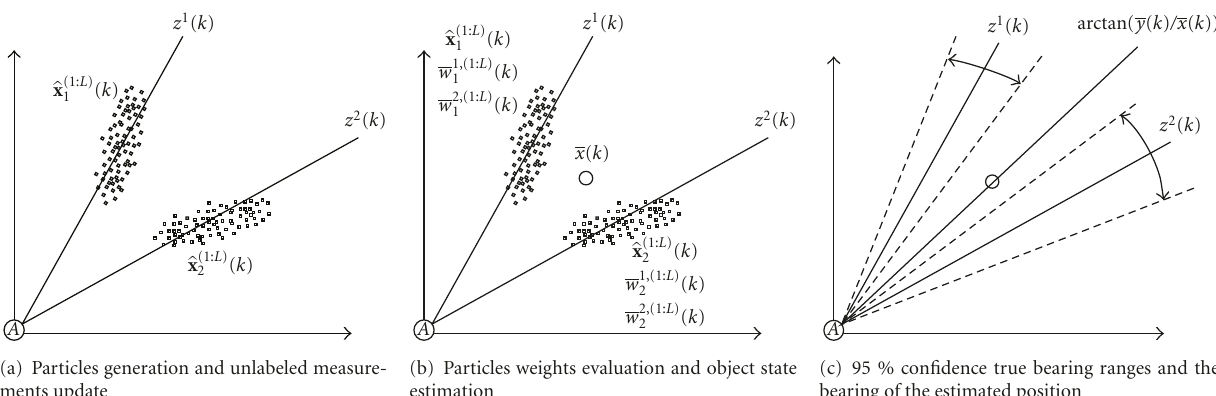
Figure 9: Deviated estimation example with multiple models and multiple measurements.